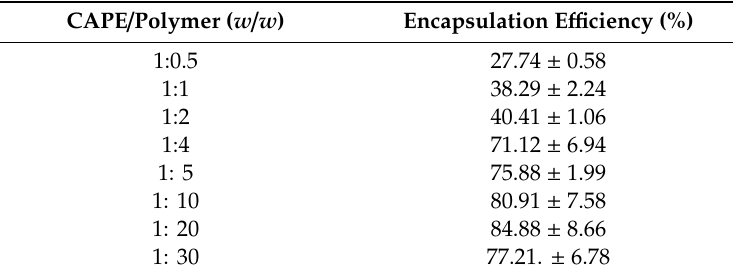
Figure 1. Schematic illustration of the construction and characteristics of CAPE-MotAb nanoparticles for targeted drug delivery. ( A ) MotAb modified with DSPE-PEG-NHS. ( B ) Structure of mortalin-targeted CAPE-MotAb nanoparticles formed by self-assembly of amphiphilic block copolymers (DSPE-PEG-NHS) with MotAb. ( C ) General mechanism of targeted action by CAPE-MotAb for cancer treatment: the nanocapsules with long blood circulation times get accumulated at the tumor region through passive targeting achieved by EPR effect and subsequently internalized by tumor cells via mortalin-mediated endocytosis. The low pH in endo/lysosomes offers an optimal environment to facilitate the CAPE escape to the cytoplasm by decomposing micelles, thus resulting in cell death. ( D ) Non-reducing SDS-PAGE analysis of CAPE, DSPE-PEG-NHS, CAPE-PEG, MotAb, and CAPE-MotAb. MotAb appeared at MW ~250-kDa, CAPE-MotAb was seen at higher molecular weight suggesting the successful conjugation of MotAb to DSPE-PEG-NHS. ( E ) UV-Vis-NIR absorption spectra of CAPE-MotAb. Characteristic peaks of MotAb at 280 nM and CAPE at 335 nM (marked with black arrows) were simultaneously observed in CAPE-MotAb showing successful encapsulation of CAPE in polymeric micelles. ( F ) Representative TEM image of CAPE-MotAb (a magnified inset is shown in the top right corner). ( G ) Quantitative size distribution of CAPE-MotAb shown as monodisperse and spherical in shape with a diameter ranging from 9 to 19 nM. Table 1. Encapsulation efficiency of CAPE-MotAb prepared with different weight ratios of CAPE powder and DPSE-PEG-NHS polymers.